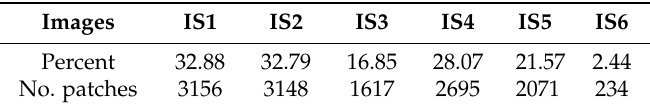
Table 8. Percent of flooded